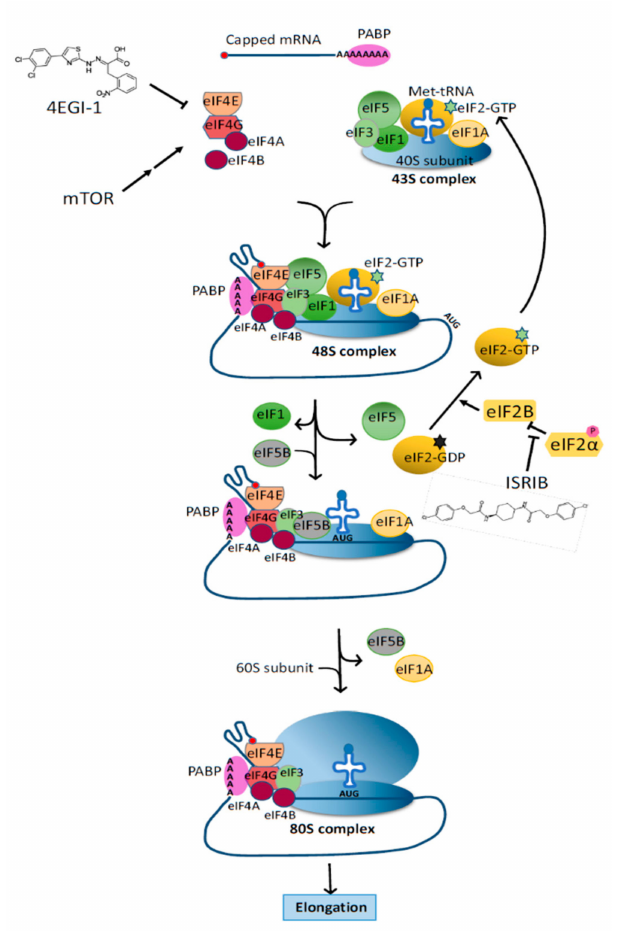
Figure 1. Regulation of Cap-dependent translation initiation. Translation begins with the recruitment of the preinitiation complex (40S ribosome, eIF1, eIF1A, eIF3, eIF5, and the eIF2-GTP-Met-tRNA i complex) to the 5 (cid:48) cap of mRNAs by the eIF4F complex (eIF4A eIF4E, and eIF4G) and eIF4B. This preinitiation complex scans the mRNA for a start codon (AUG) in a 5 (cid:48) to 3 (cid:48) manner. Upon recognition of the start codon, eIF5B mediates the release of initiation factors eIF1, eIF2-GDP, and eIF5, allowing the 60S ribosome to join and form the elongation complex 80S ribosome. eIF2B facilitates the recycling of eIF2-GDP to eIF2-GTP, but is inhibited by the phosphorylated form of eIF2 α . In many monogenic forms of syndromic autism, mTOR hyperactivation occurs as a result of disturbances in upstream signalling pathways, and in turn enhances translation initiation by direct or indirect phosphorylation of 4E-BP, eIF4B, and eIF4G. A pharmacologic inhibitor of the interaction between eIF4E and eIF4G (4EGI-1) has been shown to have therapeutic benefits for multiple ASD models that have increase translation translational dysregulation. Conversely, a small compound known as ISRIB (integrated stress response inhibitor) can nullify the inhibitory e ff ects of phosphorylated eIF2 α on eIF2B [20]. Although it